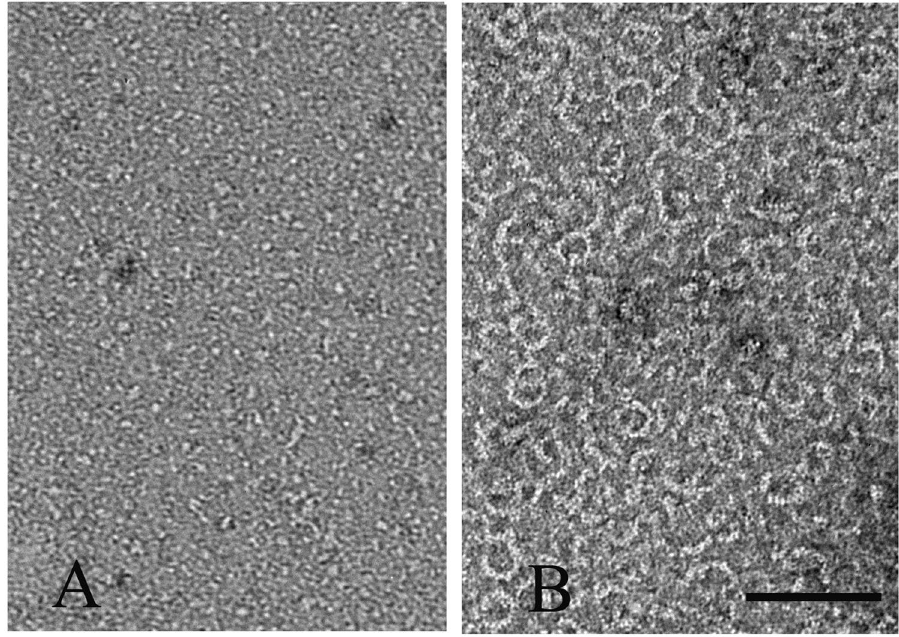
Figure 7. EM images of 5 µ M PaFtsZ alone ( A ) and with 5 µ M PaFtsZ-ZipA ( B ) in 0.5 mM GDP. The buffer is HMK, pH 7.5. Bar is 100